Question: Based on the figure, does the quantity rise or fall?
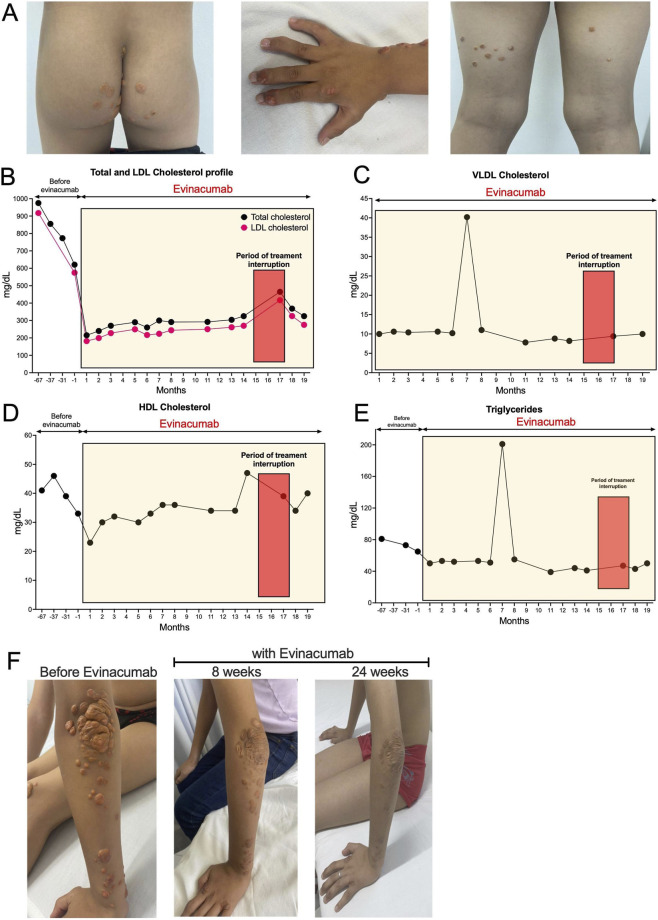
Answer: increasing